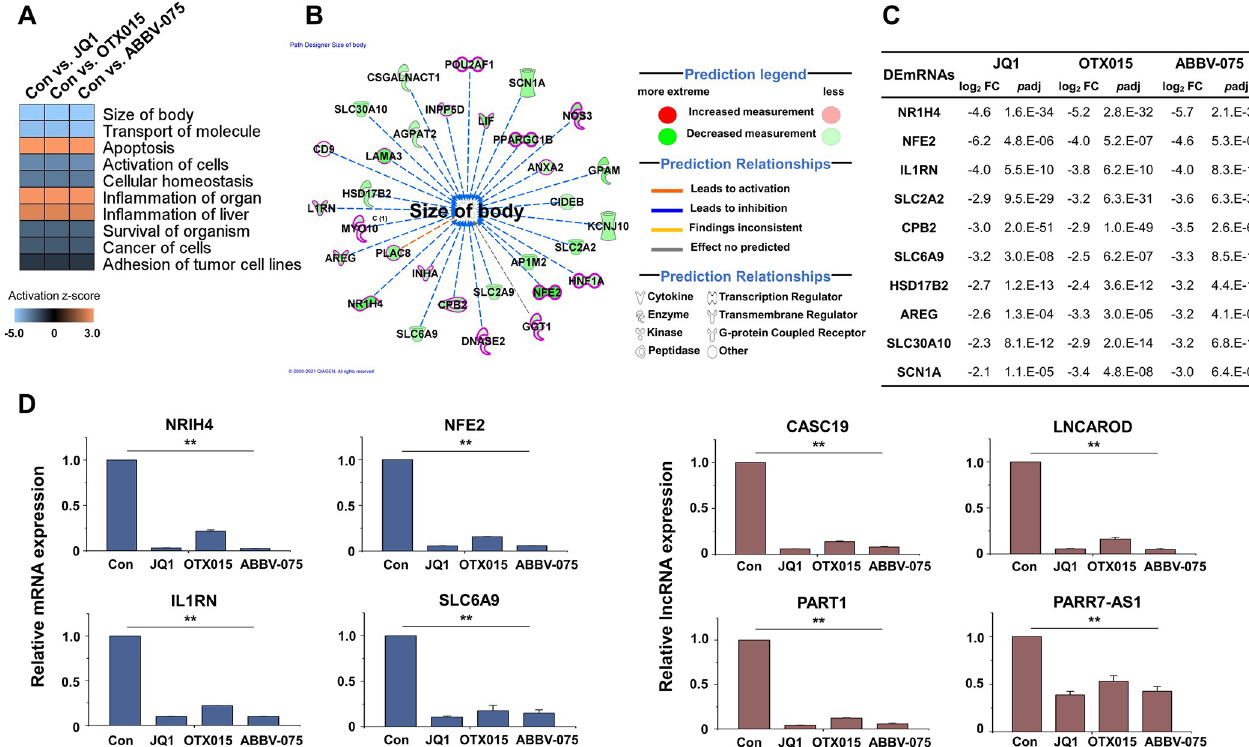
Fig 5. Biofunctional analysis of JQ1-, OTX015-, and ABBV-075-treated HCC cells. (A) Biological pathway analysis of DEmRNAs using IPA for genes of Module 1 (QIAGEN Inc., https://www.qiagenbioinformatics.com/products/ingenuitypathway-analysis). Pink cells indicate that the pathway is activated. In contrast, blue cells indicate that the pathway is inhibited, with higher Z-scores indicated by higher color intensity as shown by the color scale. (B) IPA downstream effects analysis showing the mapping of most significant genes related to the size of the body. Of the genes related to the size of the body, only cellular growth and proliferation-related genes are shown in bold and red. The DEmRNAs are colored by predicted activation state, such as activated (red) or suppressed (green). The edges connecting the nodes are colored orange (leading to activation of the downstream node), blue (leading to inhibition), and yellow (if the findings underlying the relationship are inconsistent with the state of the downstream node). (C) Log 2 fold changes and p adj in the expression of genes related to the size of the body. (D) Expression levels of the size of body-related mRNAs and lncRNAs were analyzed by qRT-PCR and normalized to GAPDH or U6 transcript levels, respectively. Overall, the size of body-related mRNAs and lncRNAs were inhibited by BET inhibitors. The data represent three independent experiments. The values are the mean ± SD of triplicate experiments ( �� p <